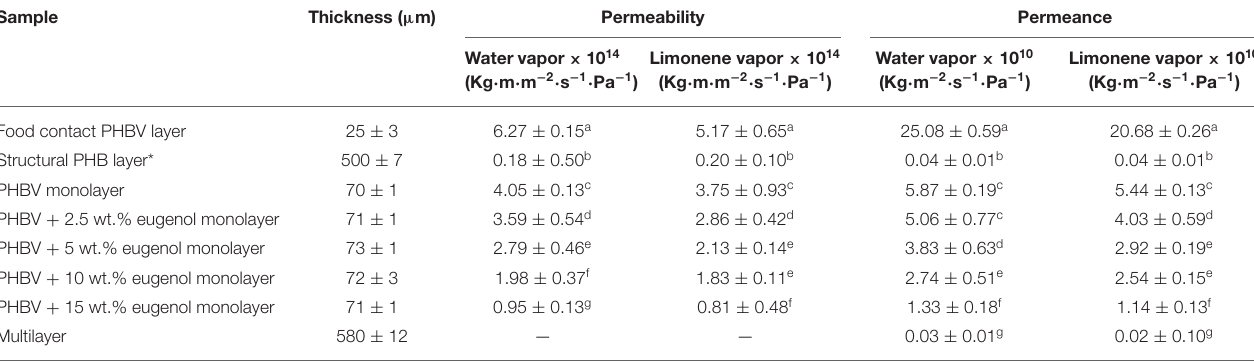
TABLE 5 | Permeance of water and limonene vapors and limonene of the structural poly(3-hydroxybutyrate) (PHB) layer, food-contact poly(3-hydroxybutyrate- co -3-hydroxyvalerate) (PHBV) layer, electrospun PHBV interlayers with different contents of eugenol, and multilayer with 15 wt.% eugenol.